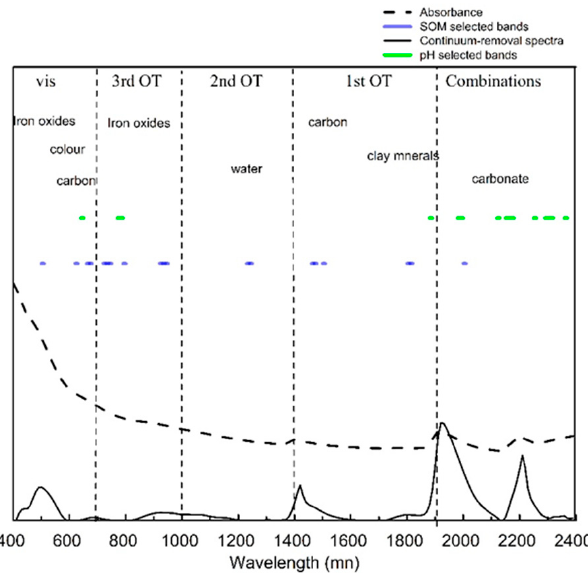
Figure 3. Mean absorbance spectra and their continuum-removal spectra and GA selected bands of SOM and pH in the calibration dataset.